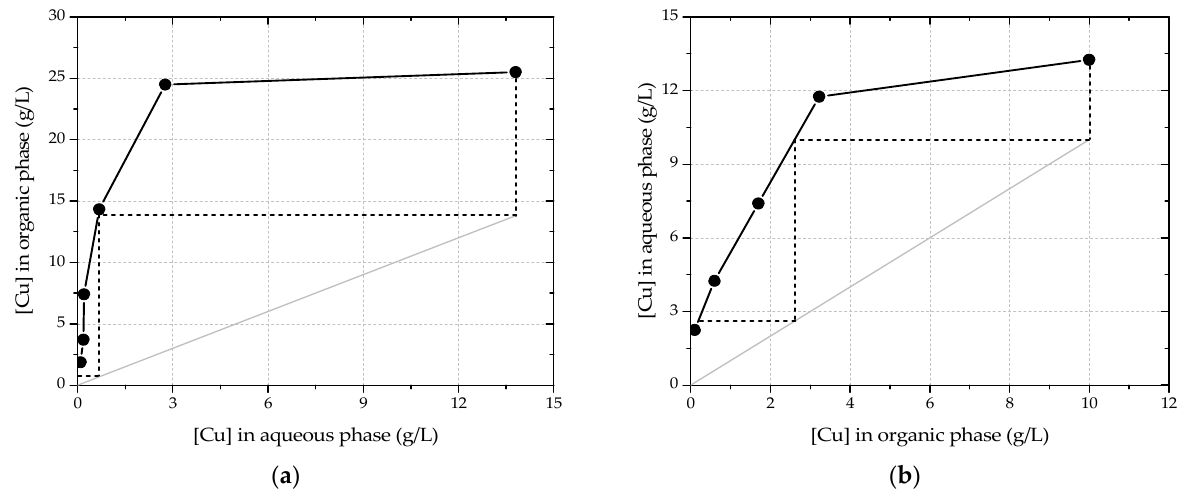
Figure 2. ( a ) McCabe–Thiele extraction diagram at equilibrium pH 1.5. The A/O ratio for the operation line is 1:1. ( b ) McCabe–Thiele stripping diagram with 2 M HCl. The A/O ratio for the operation line is